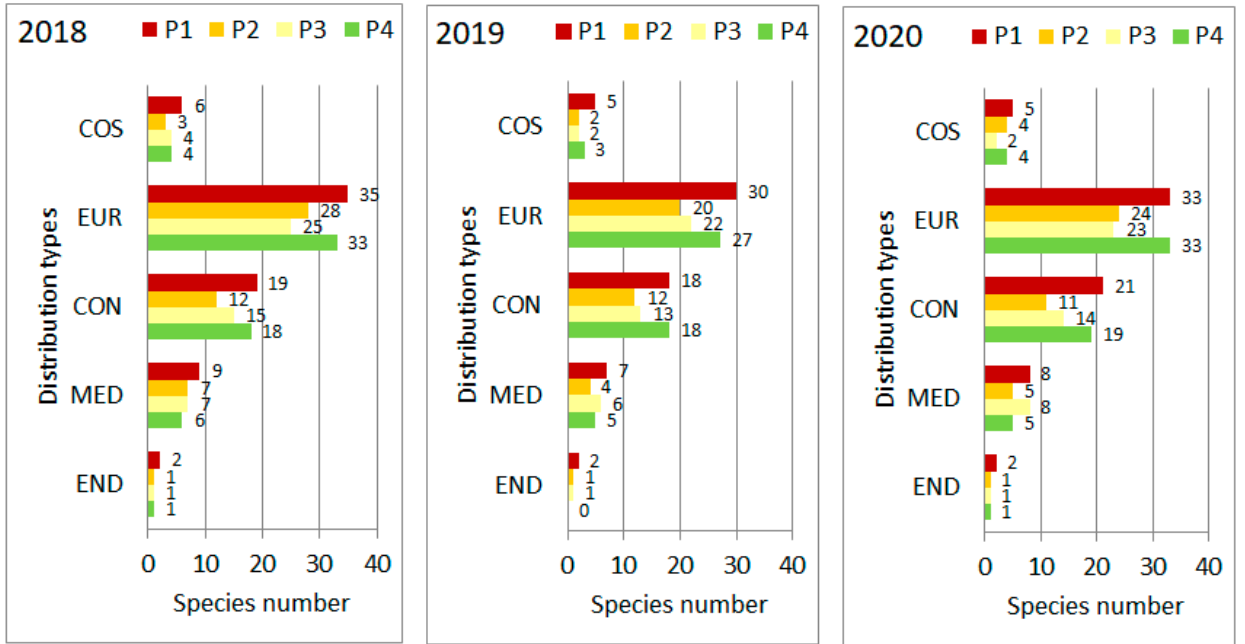
Figure 3. Share among distribution range types of species in the four plots (P1–P4) of “Pócalja” Natura 2000 loess grassland (Central Hungary), in years 2018, 2019 and 2020. COS = cosmopolitan, EUR = European, CON = continental, MED = Mediterranean, END = endemic.